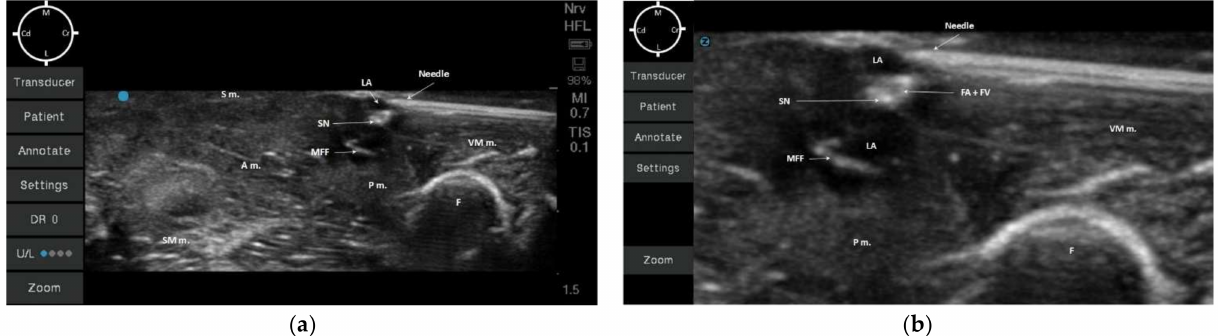
Figure 5. ( a ) Ultrasonographic image of the medial hind-limb in a rabbit cadaver at the level of medial femoral fascia (MFF). The saphenous nerve (SN) can be visualized as a hyperechoic round structure, next to other hyperechoic round structures (collapsed femoral artery and vein due to absence of blood flow), which are highlighted due to the presence of the anechoic dye solution (LA: permanent tissue dye solution and lidocaine 2% (1:50)); Once the tip of the needle pierced the medial femoral fascia, the dye solution was injected. ( b ) Highlighted ultrasound image of the injected solution within the fascia containing the saphenous nerve (using zoom option on the ultrasound